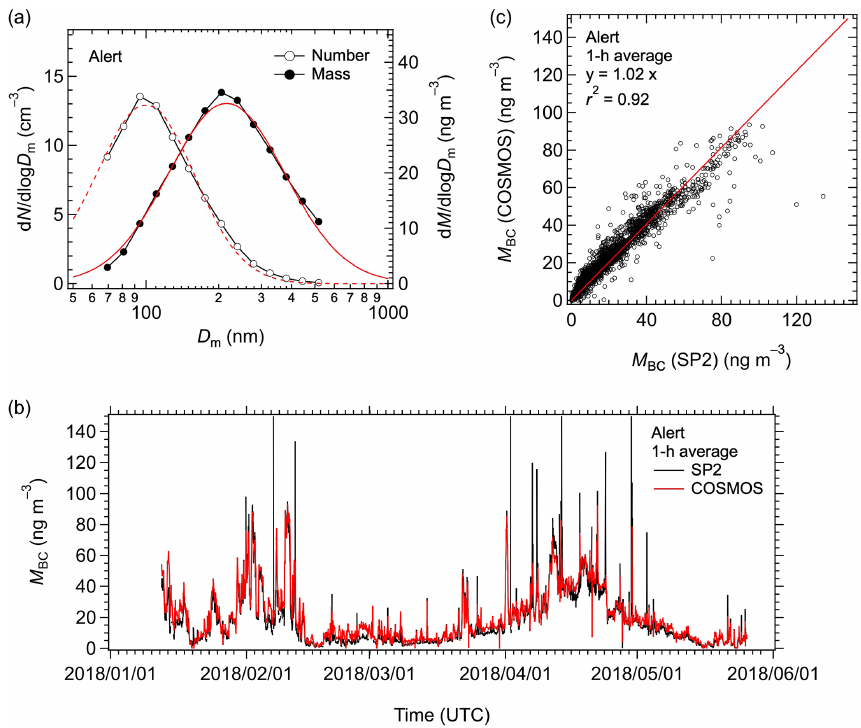
Figure 3. (a) Number and mass size distributions of BC averaged over the observation period at Alert from January to May 2018. The dashed (solid) red line is the lognormal fit to the number (mass) size distribution. (b) Time series (1h data) and (c) correlation of M BC measured by COSMOS and SP2. The solid red line in the correlation plot is the least-squares regression forced through the origin. Table 2. MAC cor (PSAP–CLAP; λ ) values at Alert during 2018–2019. r 2 is the square of the correlation coefficient. MAC cor (1h) MAC cor (24h)